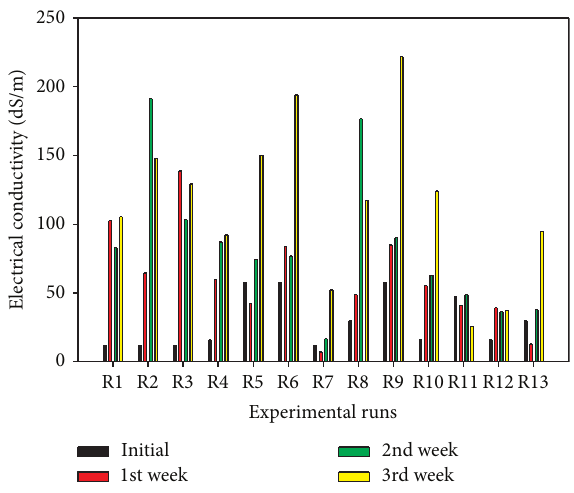
Figure 4: Weekly soil electrical conductivity